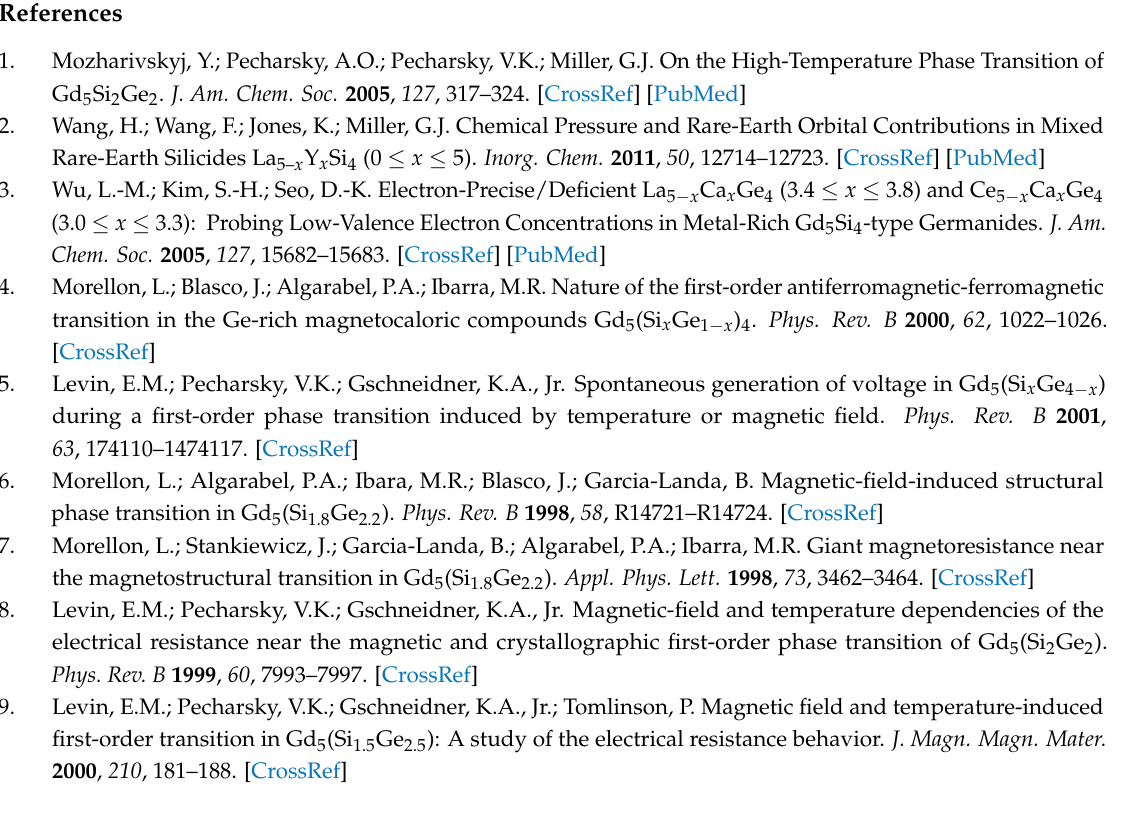
Table S1: Detailed information of a hypothetical structural model Gd 2 In 0.5 Li 0.5 Ge 2